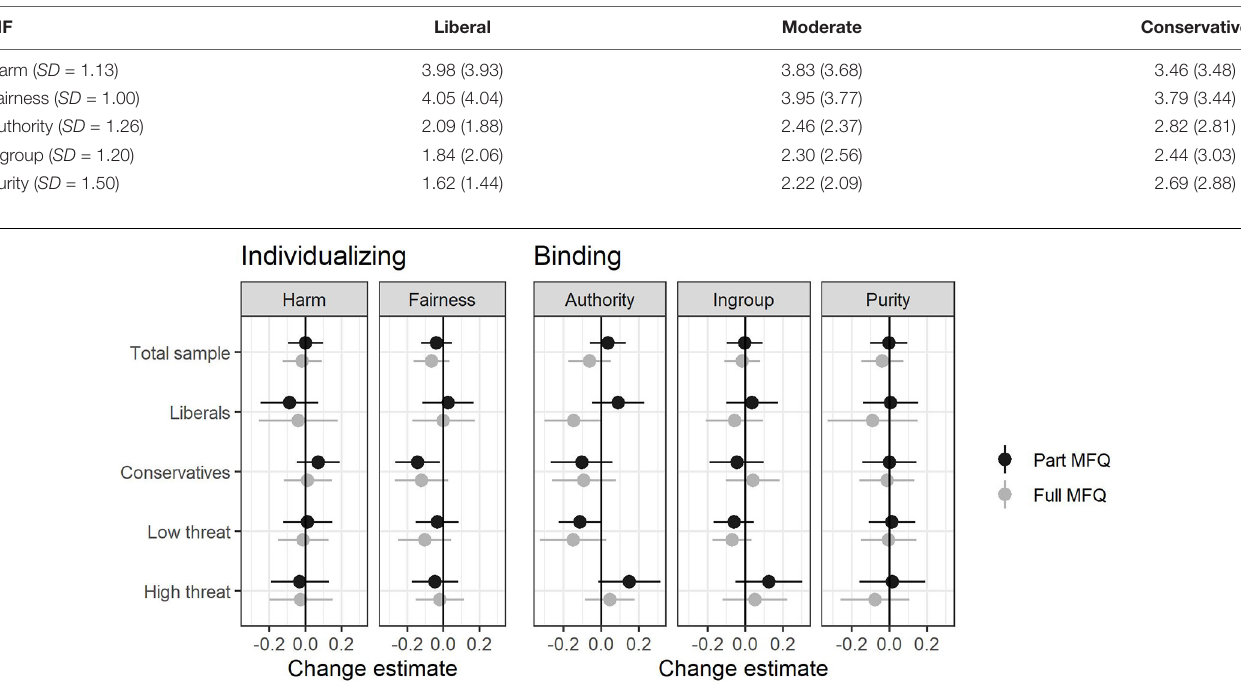
FIGURE 1 | Mean change scores for endorsement of individualizing (left) and binding (right) moral foundations in the full sample, including those who completed a part MFQ (black), and in the subsample that completed the full MFQ (gray), and in each of four subsamples defined by ideology and perceived threat from COVID-19. Error bars indicate 95% confidence